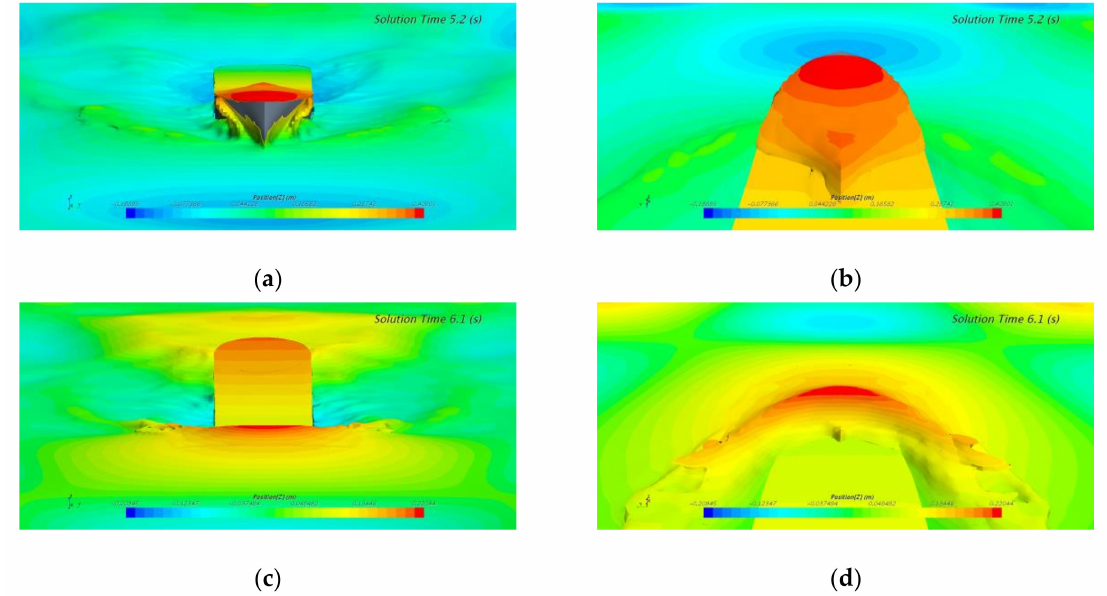
Figure 24. Front and deck view of wave impact and green water on deck ( λ / L = 1.2): ( a ) front view ( t = 5.2 s); ( b ) deck view ( t = 5.2 s); ( c ) front view ( t = 6.1 s); ( d ) deck view ( t = 6.1 s).